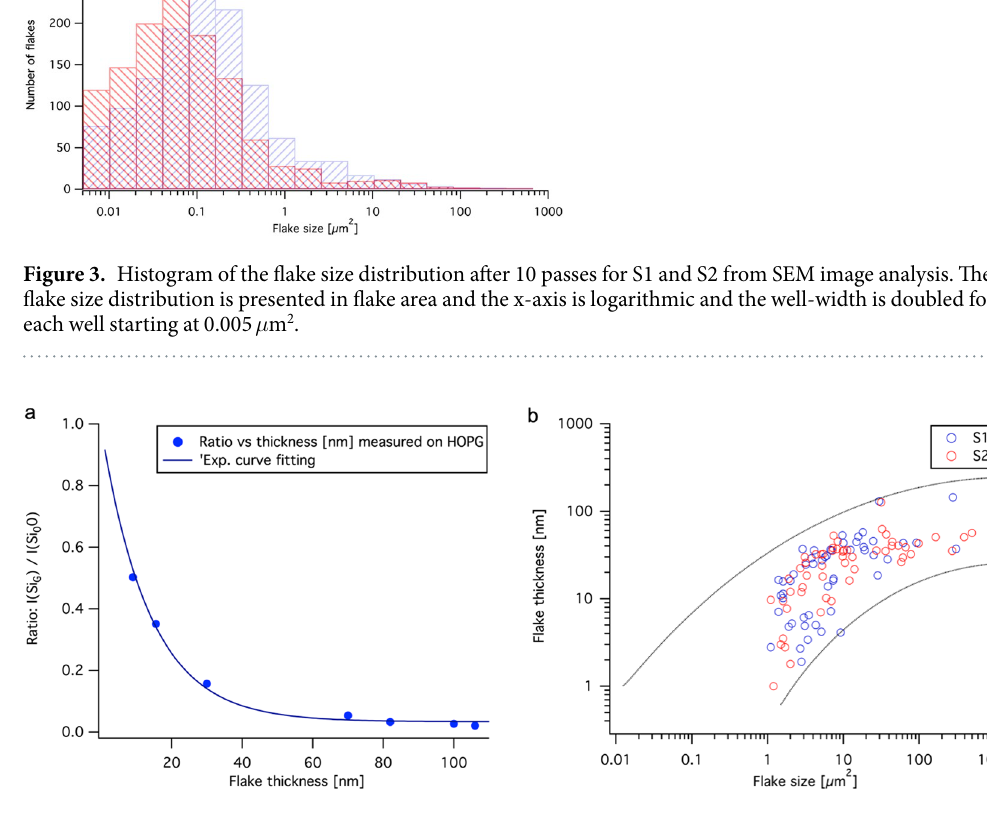
Figure 4. ( a ) The ratio I(SiG)/I(Si0) as a function of the flake thickness. The blue (°) markers shows experimental data from the tape exfoliated HOPG flakes in the Horiba XploRA PLUS Raman system as a function of the measured thickness in nm together with a fitted trend line. ( b ) Flake thickness distribution for S1 and S2 after 10 passes together with one upper and one lower trend